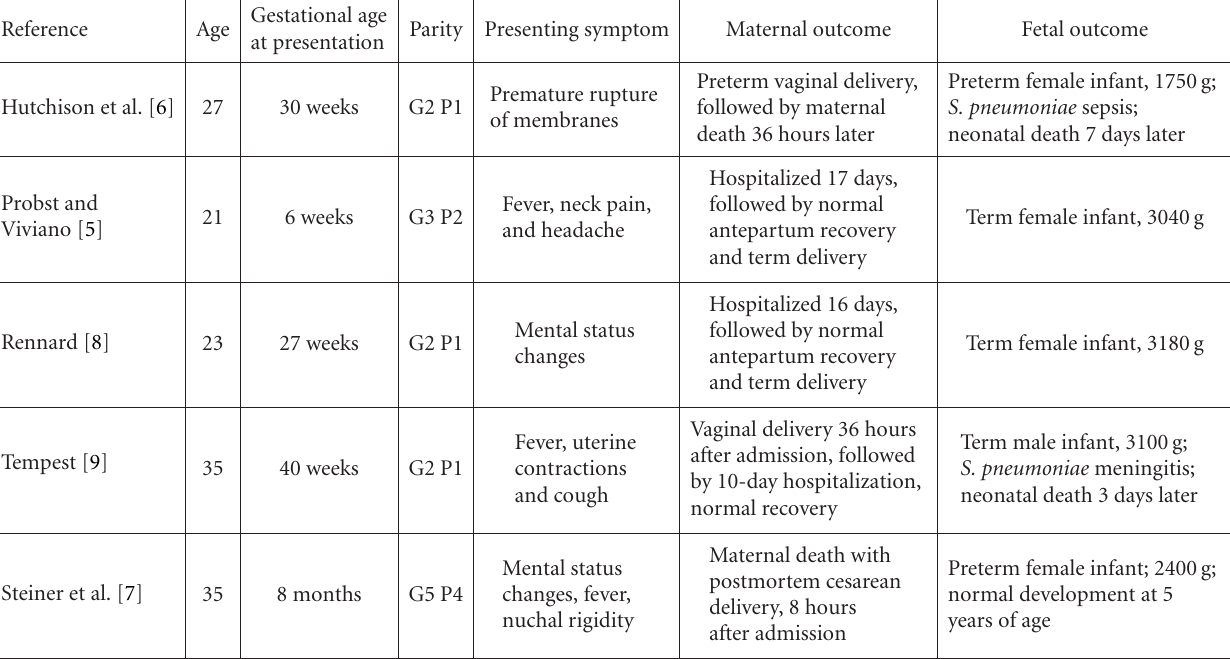
Table 1: Reported cases of pneumococcal meningitis during